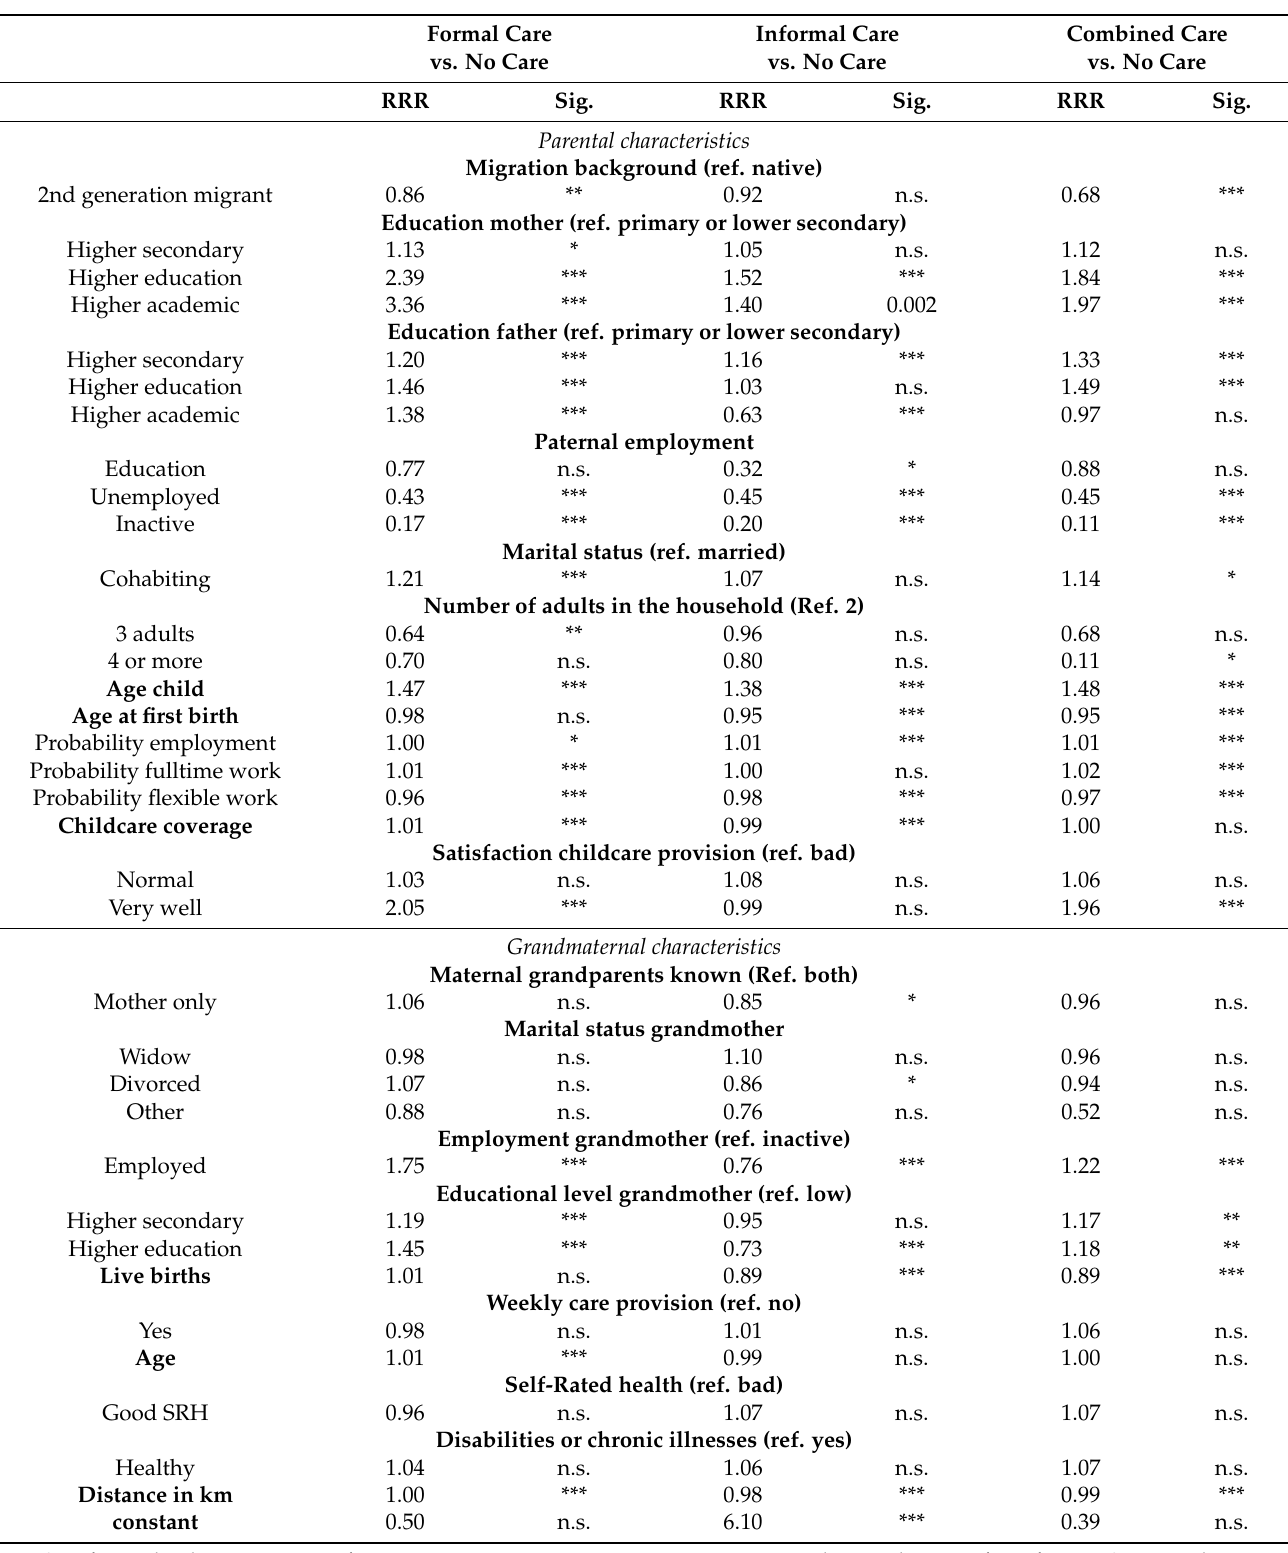
Table 2. Multinomial analysis: uptake of childcare arrangement by grandmaternal characteristics and formal childcare availability, relative risk ratios, Belgium,